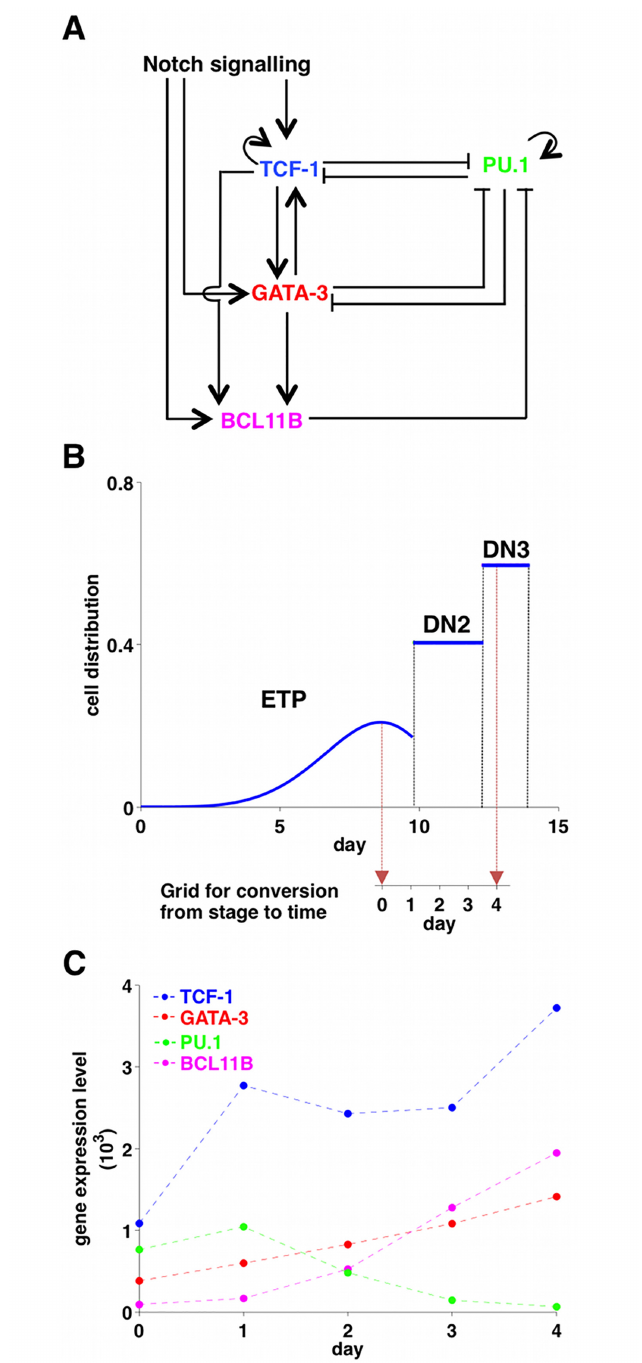
Fig 1. Core gene regulation in T-cell development. (A) A minimal gene regulatory network for T-cell specification. (B) From stage series to time series. In vivo cell distributions at ETP, DN2, and DN3 stages (adapted from [45]). The mean transit time in the ETP stage is 10 days circa, but most of the ETP cells are produced at the end of the 10 days, after several cell divisions: that justifies the lag of only 1 day between ETP (day 0) and ETP-DN2a (day 1). The mean transit time between DN2a and DN3a is about 3 days, so we decided to separate ETP-DN2a, DN2a (day 2), DN2b (day 3), and DN3a (day 4) by lags of 1 day each. (C) Gene expression profiles of TCF-1 (blue), GATA-3 (red), BCL11B (magenta), and PU.1 (green) at the fundamental stages of T-cell specification (adapted from [17] according to our conversion stage to time). The dashed lines were added to underline the trends of the gene expression profiles. The errors, which are shown